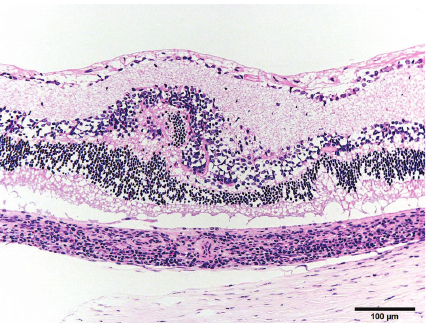
Figure 5: Photomicrograph of the iris of the eye from a 50-week- old female SDT fatty rat. There are inflammatory cells including a neutrophil (arrow), a macrophage (blue arrow head), and a lymphocyte (red arrow head) in the iris and the anterior and posterior chambers. Bar = 20 𝜇 m. Hematoxylin and